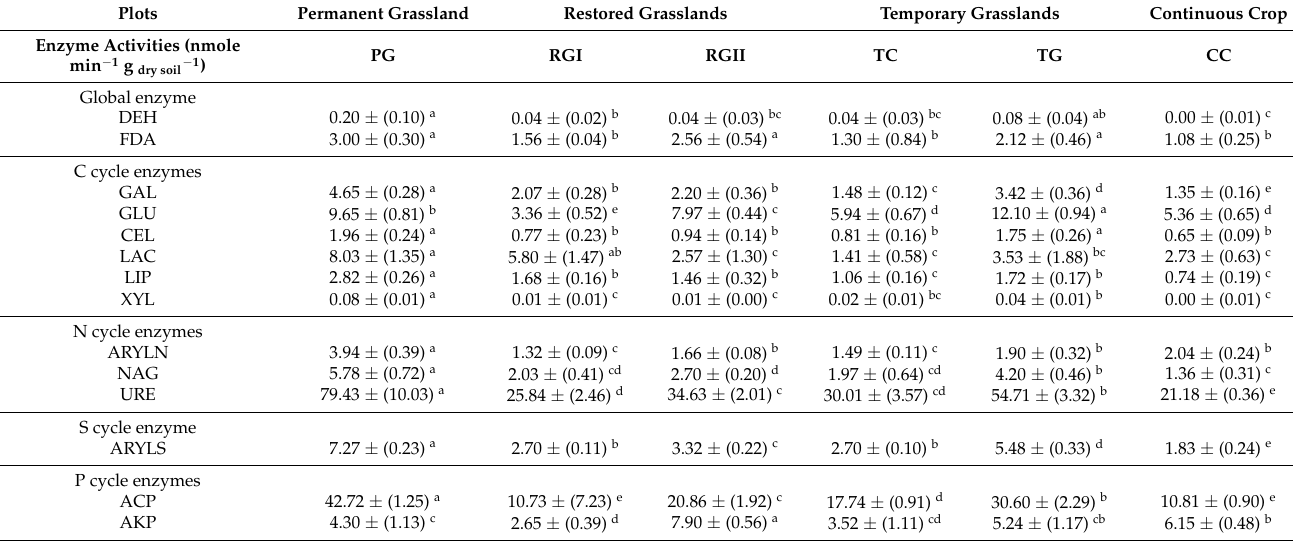
Table 6. Enzyme activities of plots.